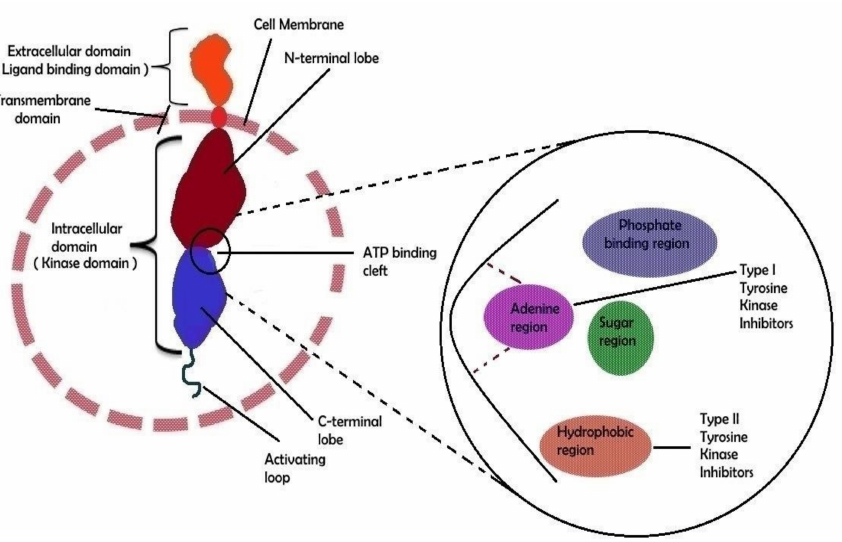
Figure 2. Molecular structural feature of RTK. A receptor tyrosine kinase’s extracellular domain can bind particular ligands such as growth factors, whereas the intracellular domain is responsible for the kinase’s (auto)phosphorylation. The external and internal domains are separated by the transmembrane region which is fixed in the cell membrane. The ATP-binding cleft is located between the two lobes of the intracellular domain. A schematic depiction of the ATP binding cleft with its numerous regions is shown on the right side of the image. Type I and type II tyrosine kinase inhibitor binding sites have been shown in biochemical general structure